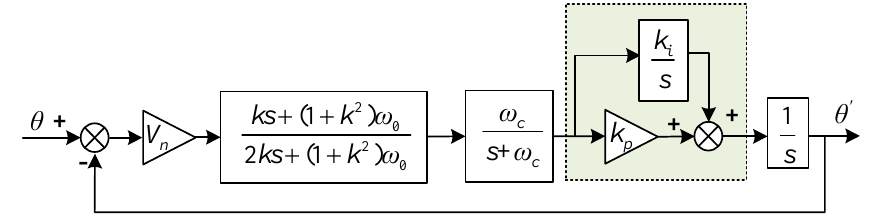
Figure 8. Small-signal model of CCF-MFOF-PLL.